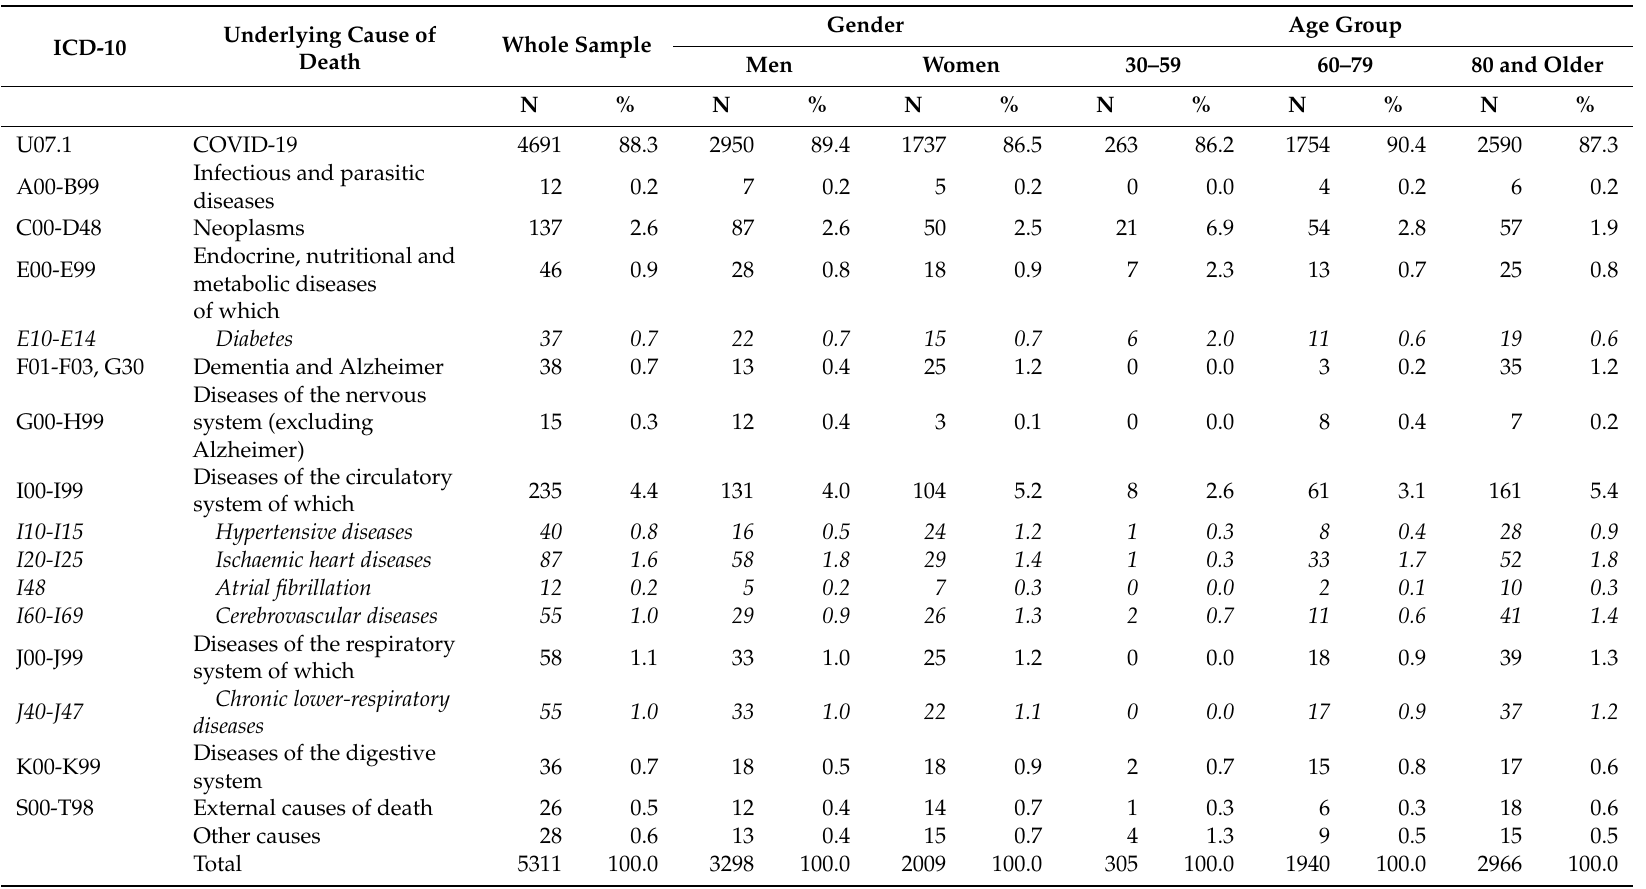
Table 1. Underlying causes of death by gender and age